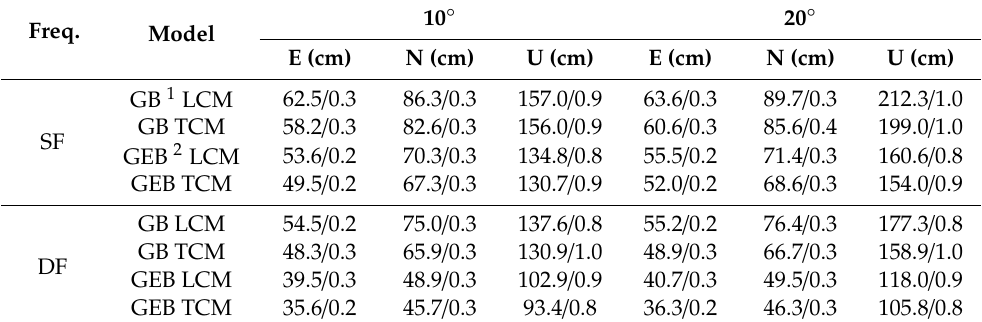
Table 6. STDs of float / correctly-fixed single-epoch RTK errors in the North, East, and Up. Freq.